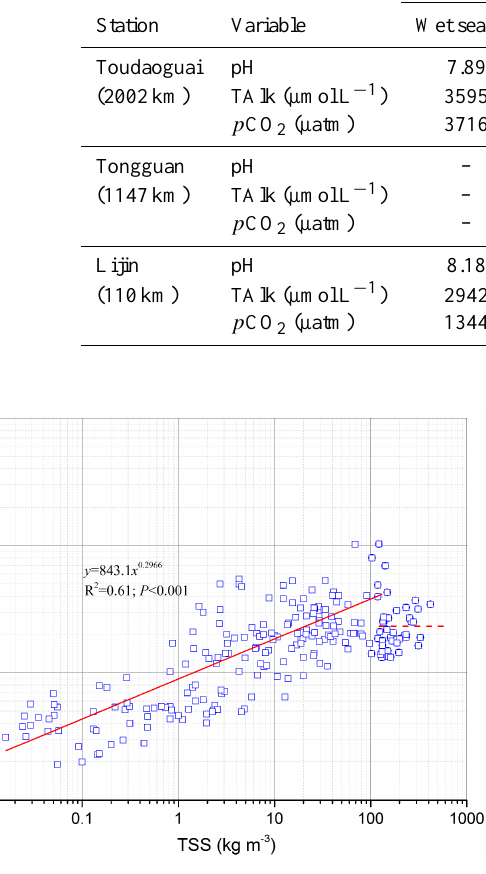
Figure 6. Relationship between total suspended solids (TSS) and p CO 2 based on measurements on the Loess Plateau. The solid line denotes the fitted line for the TSS concentration ranging from 0 to 100kgm − 3 , and the dashed line indicates the stable trend of p CO 2 when the TSS concentration is higher than 100kgm − 3